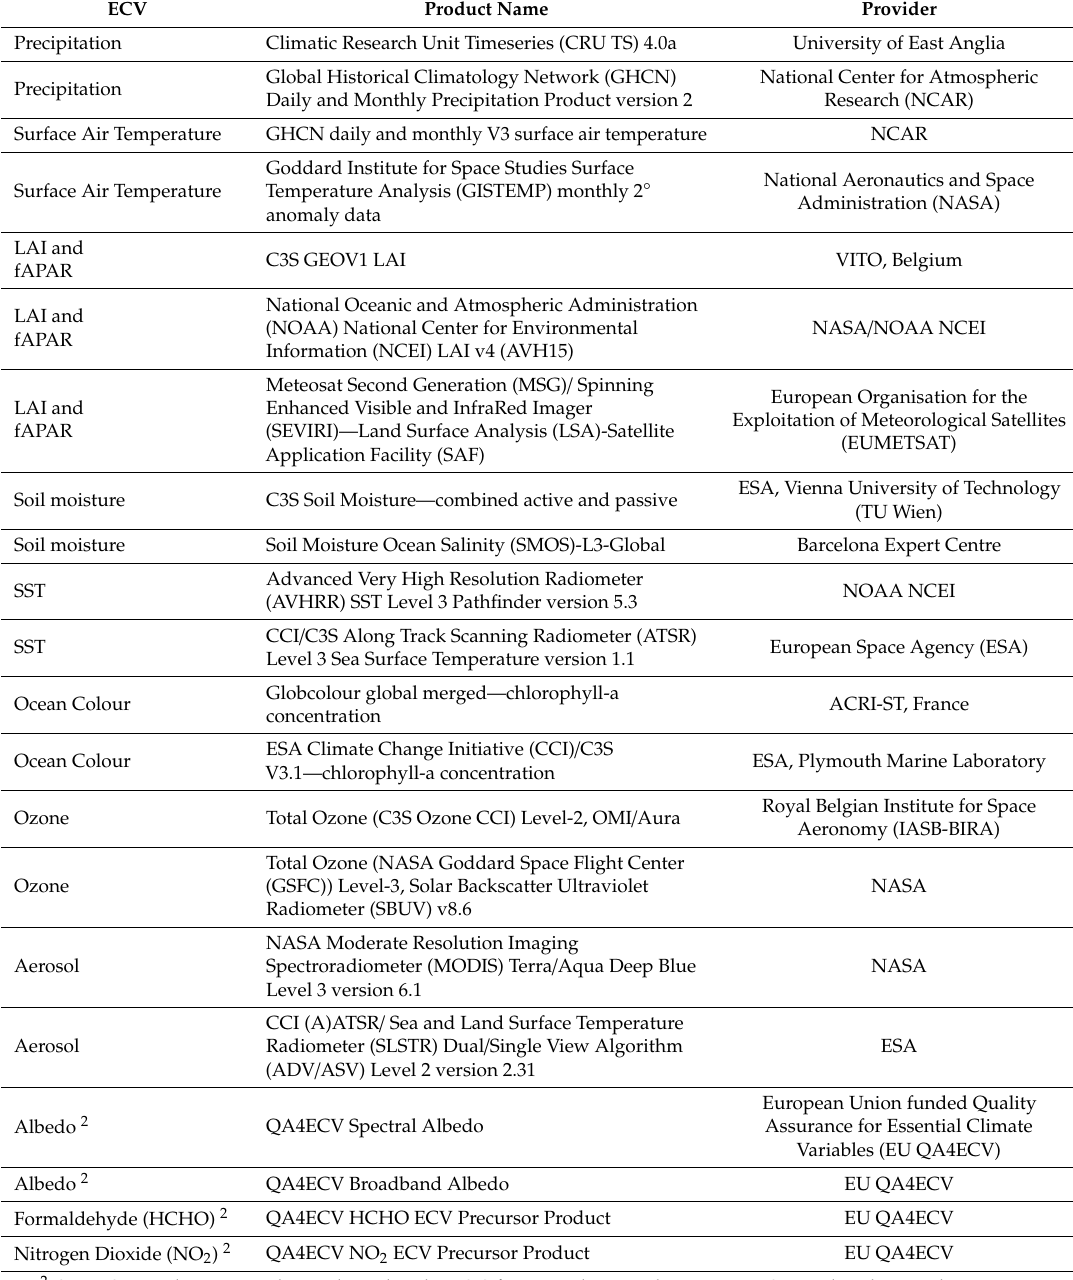
Table 2. The filtered data products that underwent detailed scientific analysis for quality information